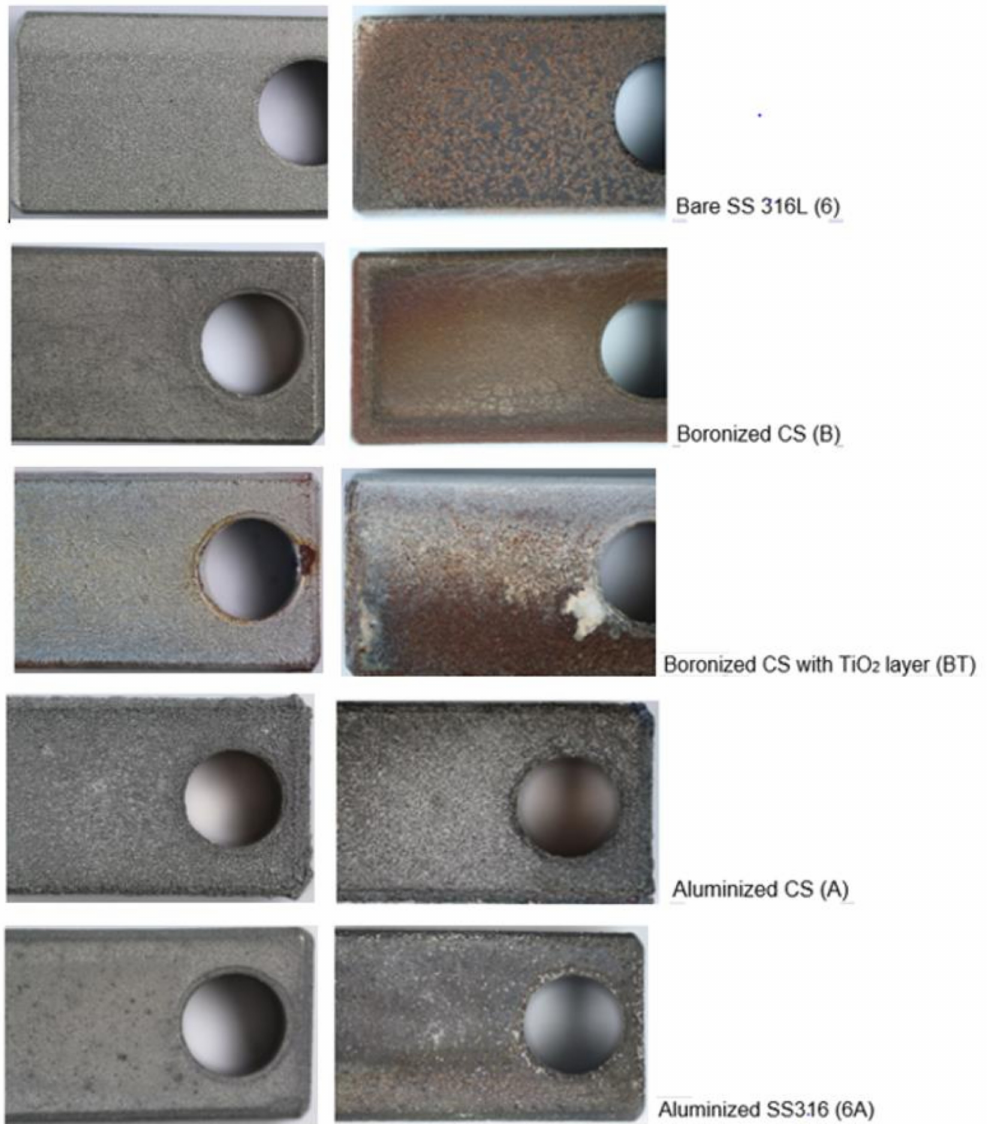
Figure 3. Appearance of the samples prior to corrosion testing ( left ) and after sulfidation-oxidation (H 2 S-air, 500 ◦ C) for 504 h ( right